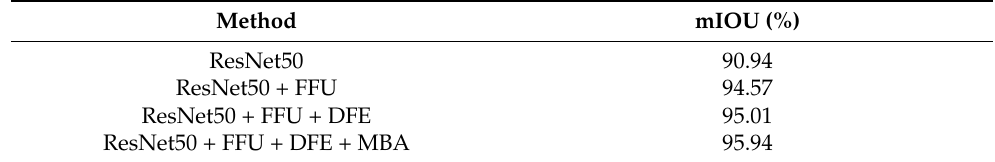
Table 2. Comparison of the effects of different modules on the